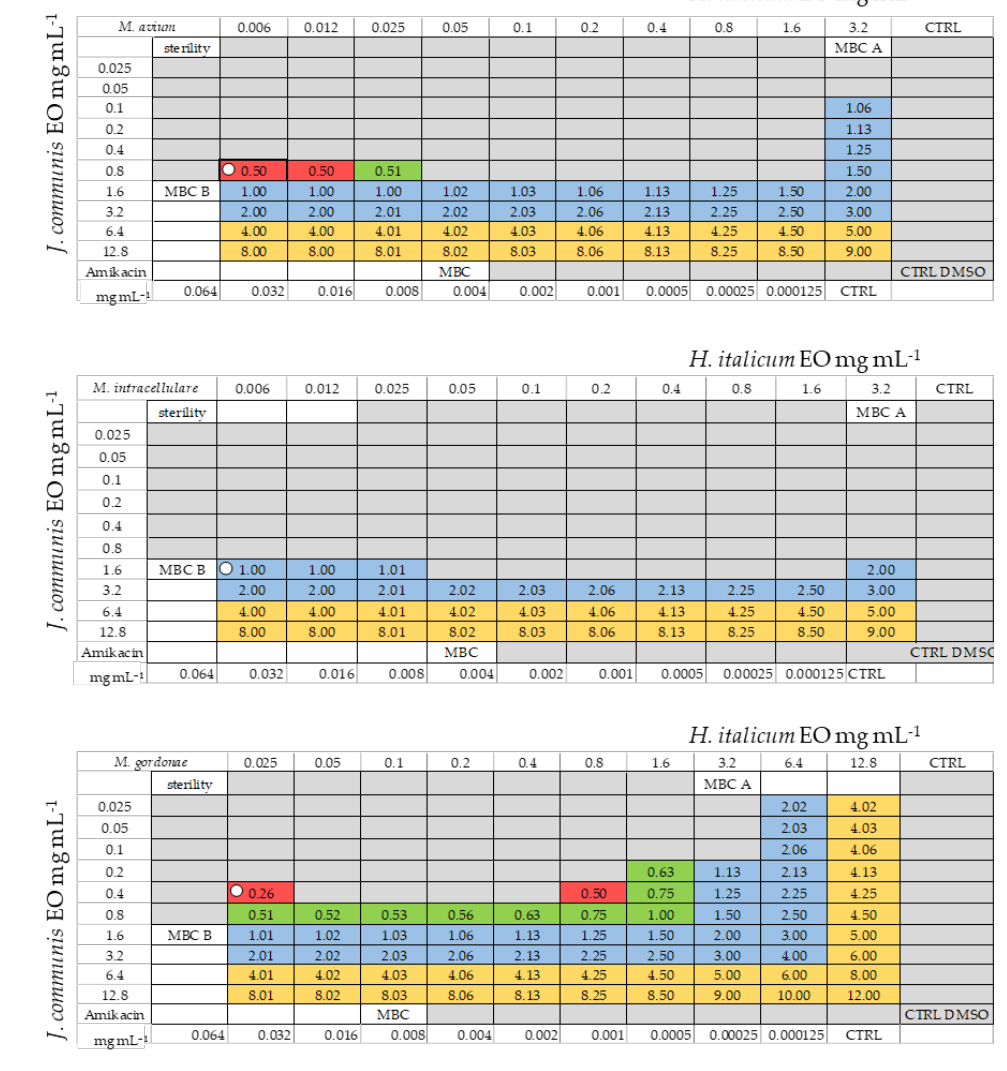
Figure 2. Checkerboard synergy method for the potential interaction of J. communis and H. italicum EOs on NTM. MBC—minimal inhibitory concentration; FBC—fractional inhibitory concentration; FBC i —fractional inhibitory concentration index; CTRL—control; EO—essential oil.